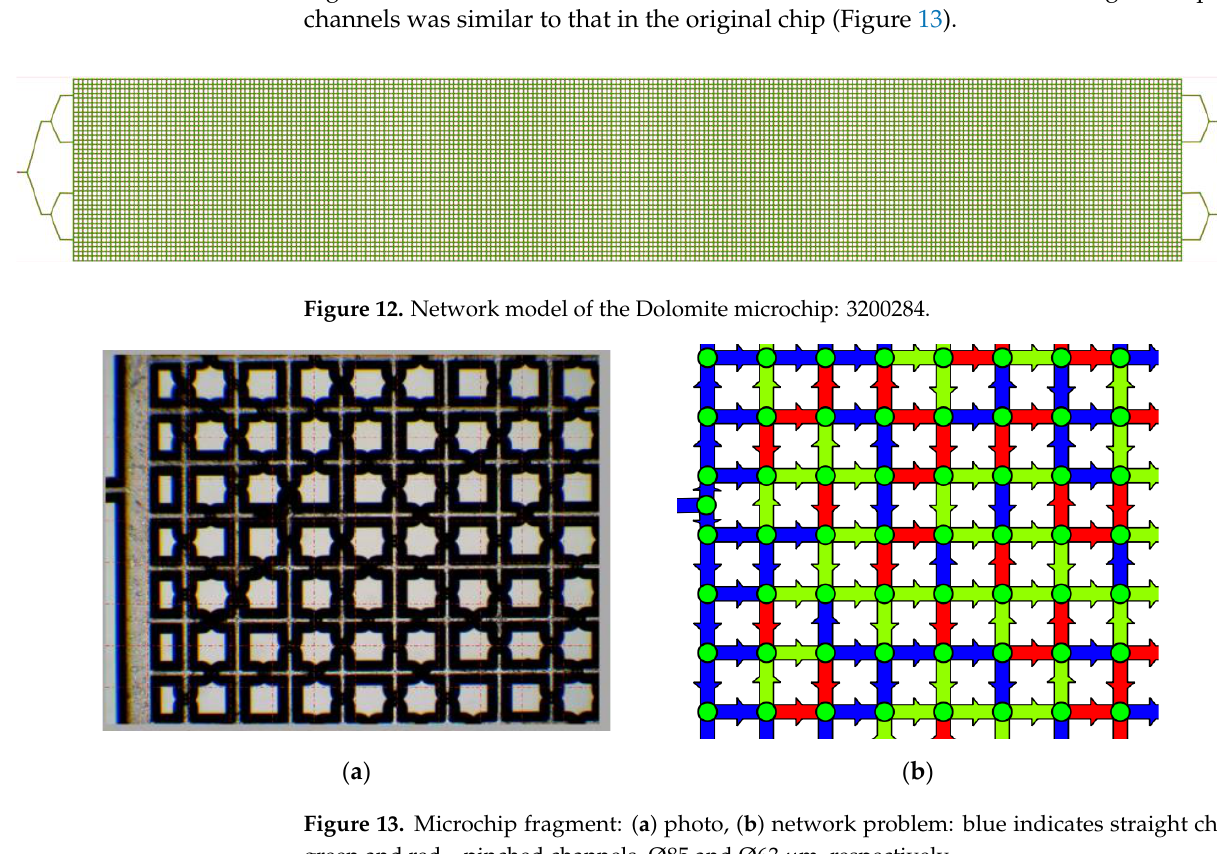
Ø 85 ( a ) and Ø 63 ( b ) microns.